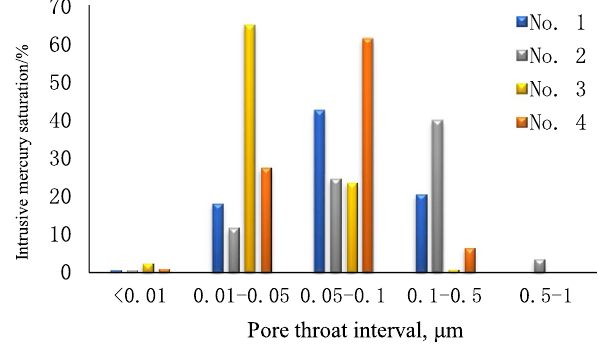
Fig. 7 Pore intrusive mercury saturation in different pore throat inter-